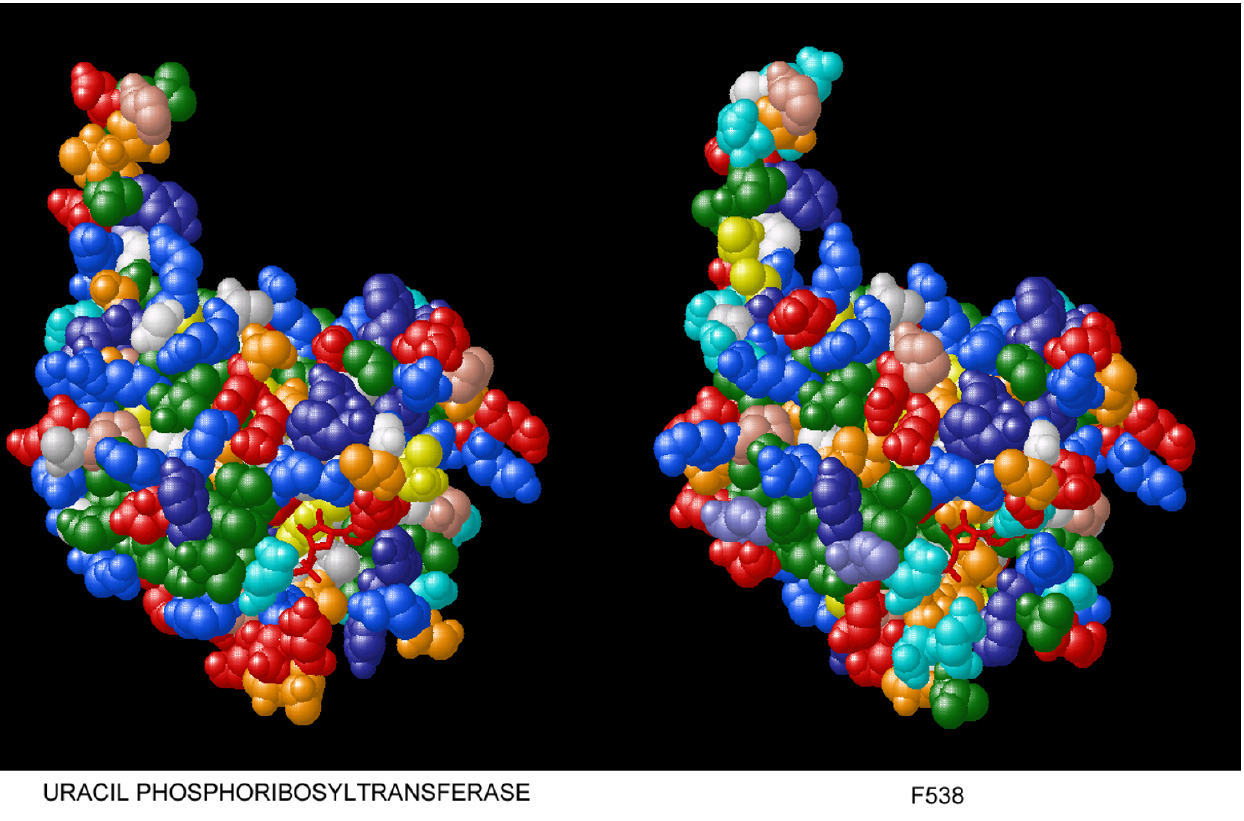
Figure 7 Predicted 3D structure of F538 (aa 309–542) as space fill model in comparison to the crystal structure of T. gondii UPRT (2.5 Å resolution – Schumacher et al , 1998). The bound UMP is